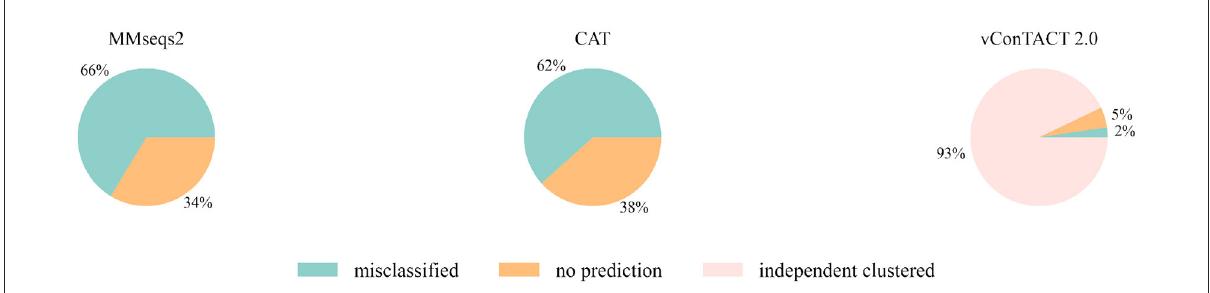
FIGURE3 The classification result of 2,445 unclassified sequences. “independent clustered”: The sequences are in a VC cluster without any reference genome.